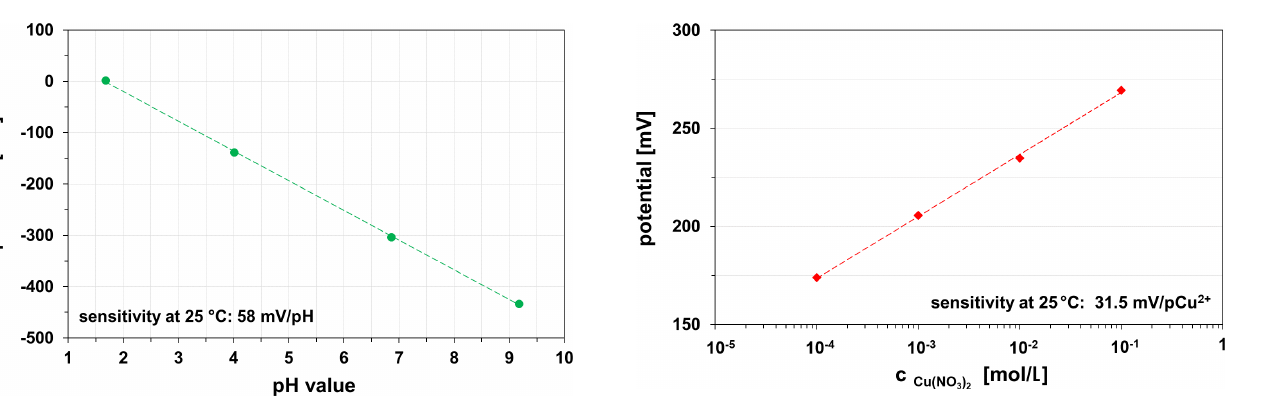
Figure 11. Calibration curve of Cu 2 + ISE in the measurement